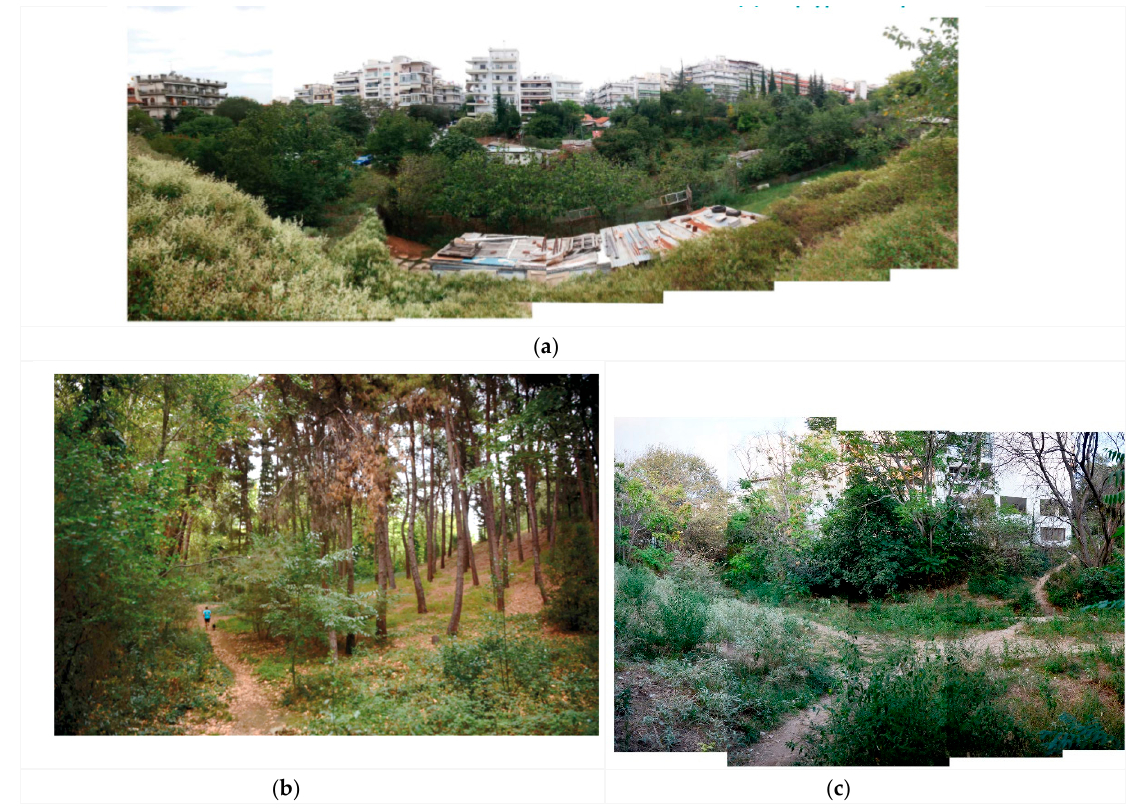
Figure 5. ( a – c ) Stream Polygnotou. Landscape Units: top, Unit II open gorge type landscape, bottom-left, Unit I the forest-like ecosystem and bottom-right , the channelized bank within a flat meadow-like